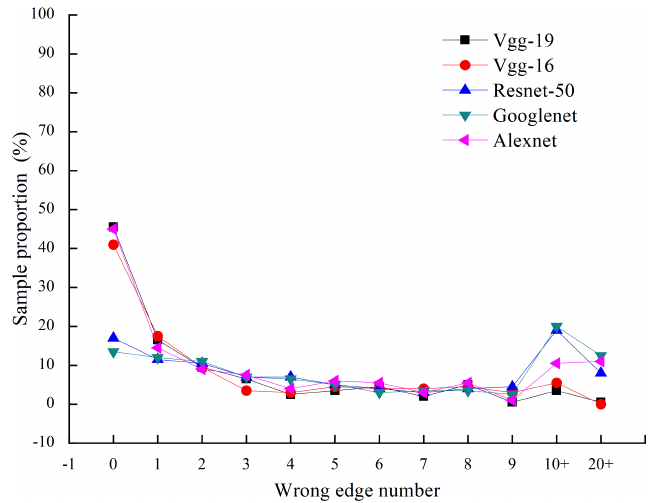
Figure 16. The performance of five CNN models in the test